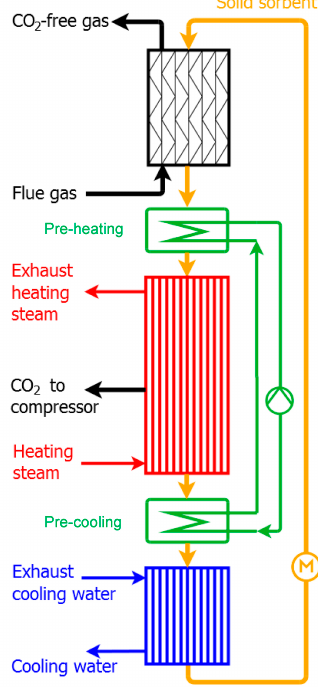
Figure 1. Schematic diagram of the MBTSA system.